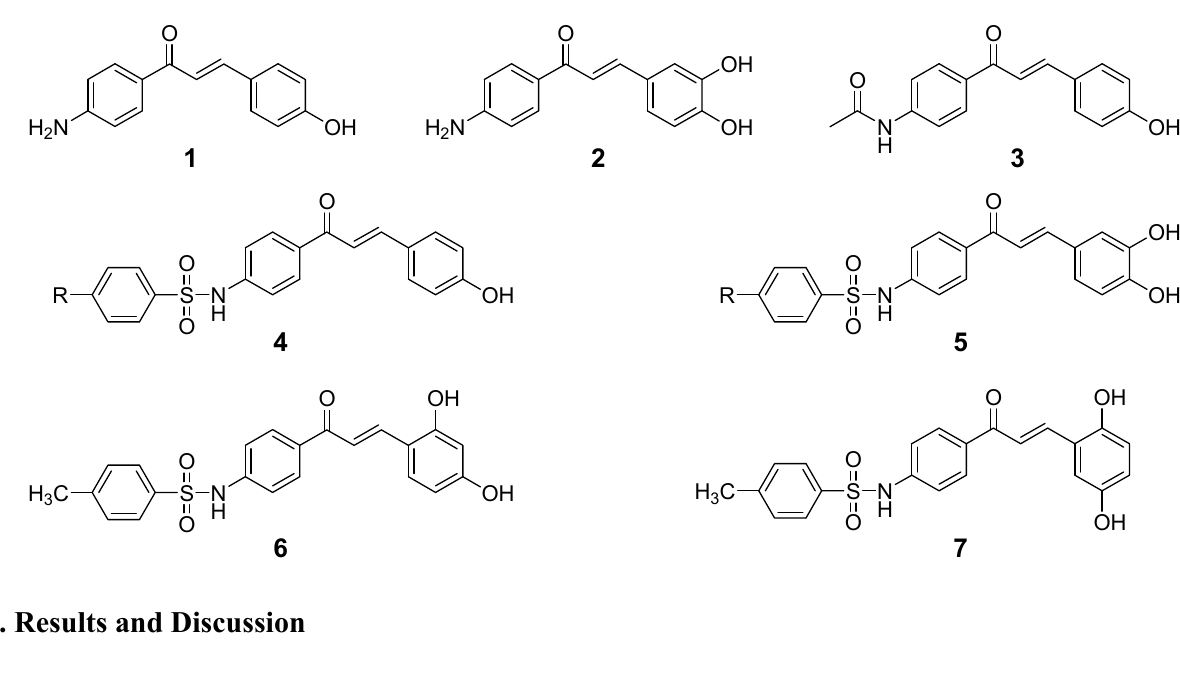
Figure 1. Chemical structures of chalcone